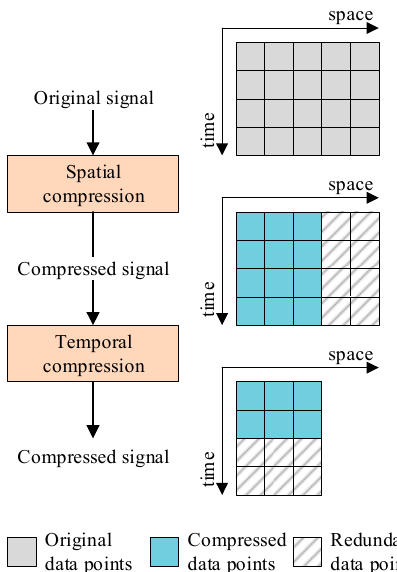
Figure 3. Basic principle of the spatiotemporal data compression.